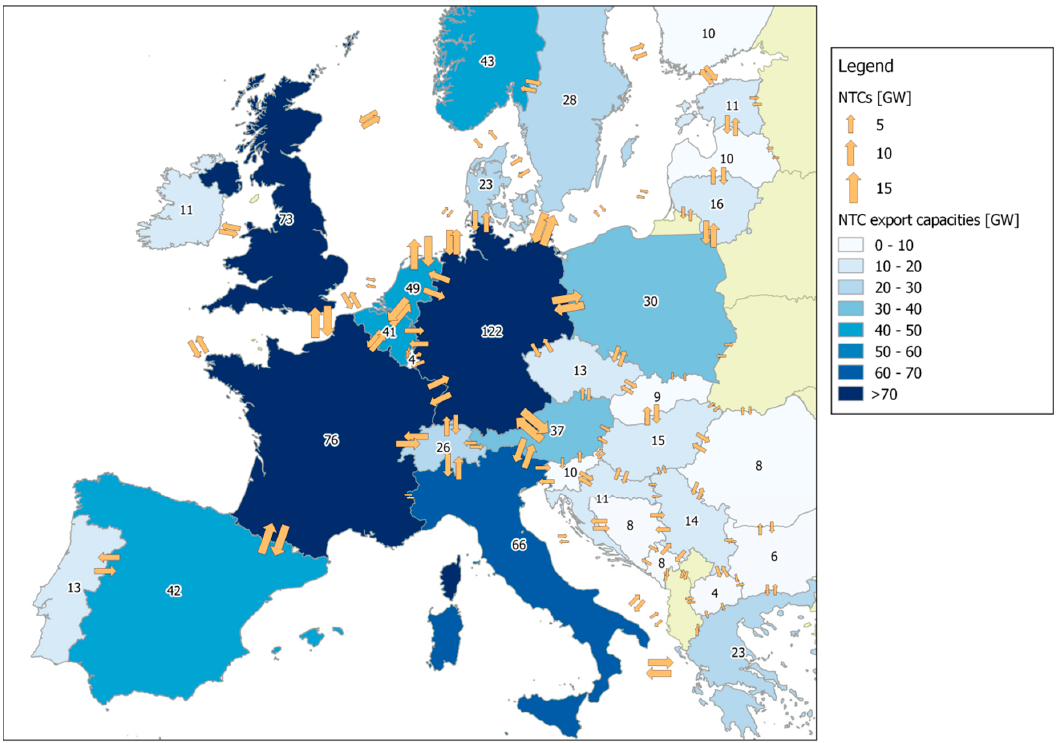
Figure 7. NTCs between the countries considered and their sum of export capacities in the high connectivity scenario for the year 2050. Source: Reference [29].